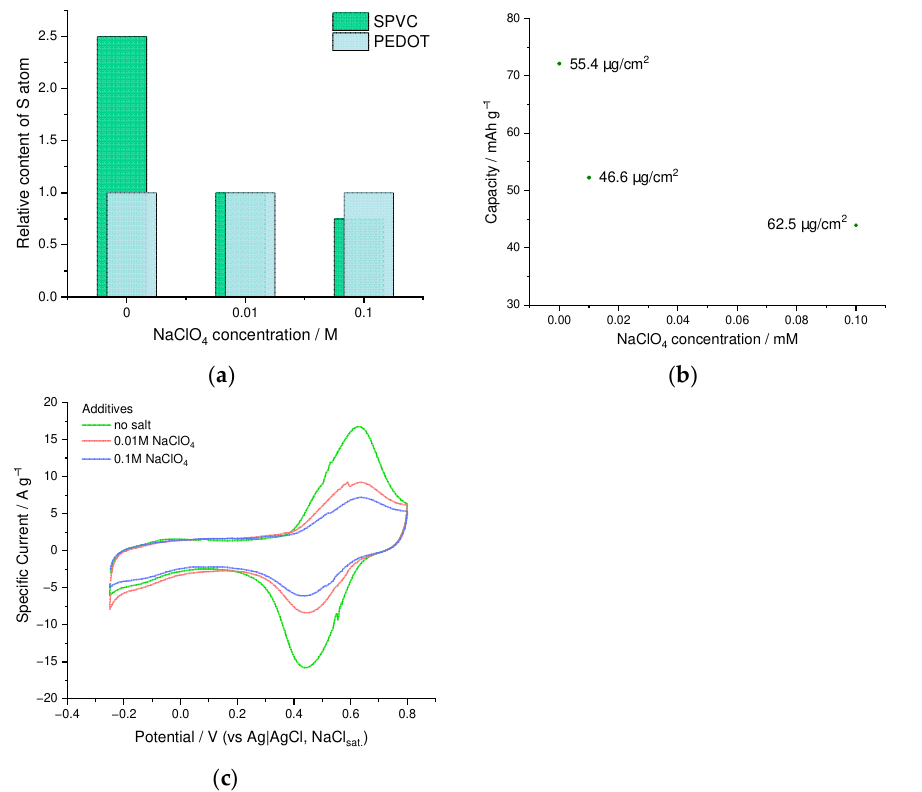
Figure 3. ( a ) SPVC to PEDOT ratio by XPS, ( b ) gravimetric capacity vs. NaClO 4 concentration and ( c ) CV curves (20 Mv·s −1 , 0.1 mM HClO 4 /H 2 O) for PEDOT:SPVC films deposited with different NaClO 4 additives; deposition from 5 mM EDOT + 10 mM NaSPVC, 10% CH 3 CN in H 2 O.